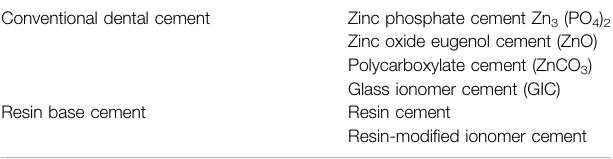
TABLE 1 | Classi fi cation of dental cements. Conventional dental cement